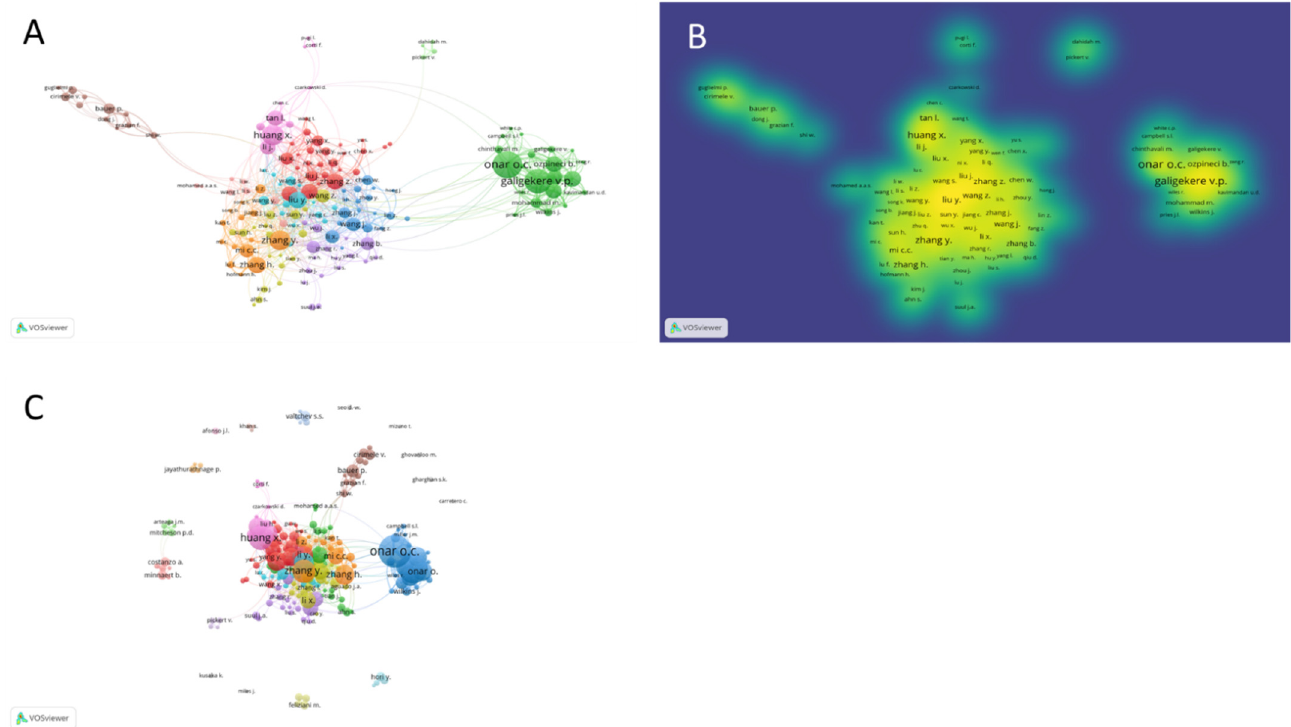
Figure 5. Largest set of connected items for network ( A ) and visualization density ( B ) of author co-authorships. This network and visualization density map ( A and B respectively) depicted the 163 items with 844 links and 11 clusters. 202 out of 3074 authors met the criteria of at least five documents to be published by an author and minimum citations was set at zero. The network ( C ) depicted some clusters/items that were not connected.